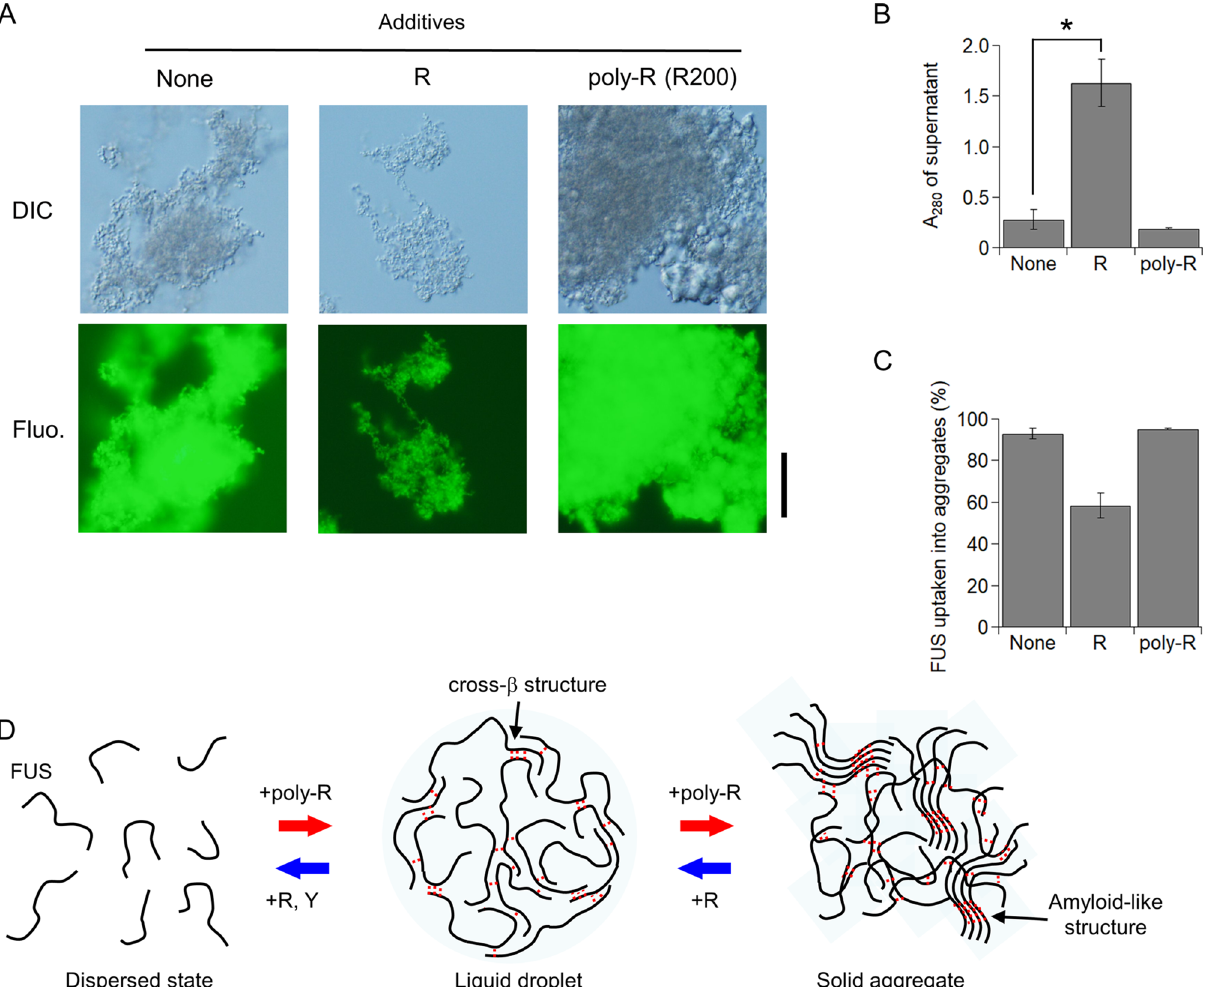
Figure 4. Arg additive suppressed the aggregation formation of FUS, while poly-Arg promoted it. ( A ) Effect of Arg and poly-Arg additives to FUS aggregate formation detected by DIC and fluorescence microscopy. The aggregates were formed after MBP-tag cleavage in the absence of dextran. The fluorescence of amyloid sensitive PicoGreen was detected. "None" denotes the absence of additives. Scale bar denotes 20 µm. ( B ) Absorbance of soluble fraction at 280 nm in FUS aggregate solution in the absence/presence of Arg and poly-Arg additives. Asterisk indicates a significant difference ( p = 0.01, two-tailed t-test). ( C ) Percentage of FUS molecules taken up into aggregates in the absence/presence of Arg and poly-Arg additives. In ( B , C ), error bars represent the standard errors ( N = 3). ( D ) Schematic diagram of effect of additives on the liquid droplets and solid aggregates. Dashed red lines represent intermolecular